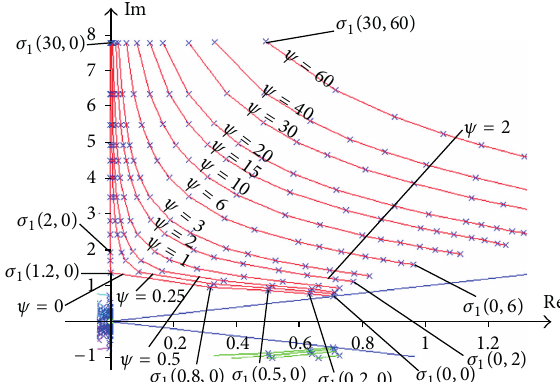
Figure 5: Poles of the closed-loop system in the 𝜎 -plane: details of the stable underdamped